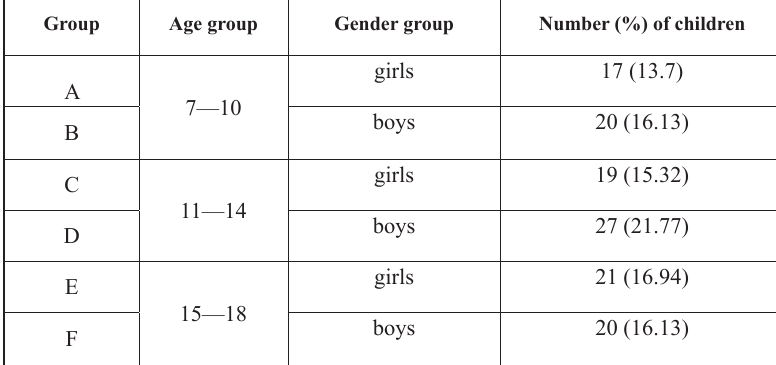
Table 1. The distribution of participants according to gender and age